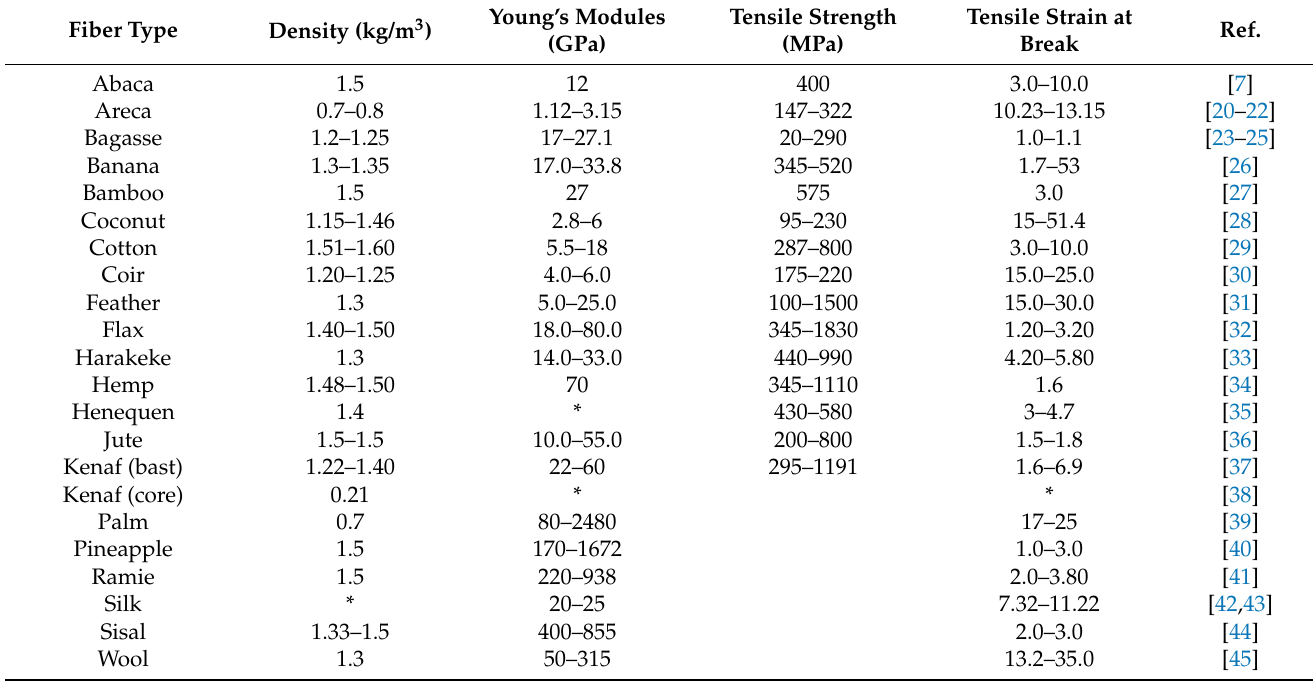
Table 2. Strength properties of different NF